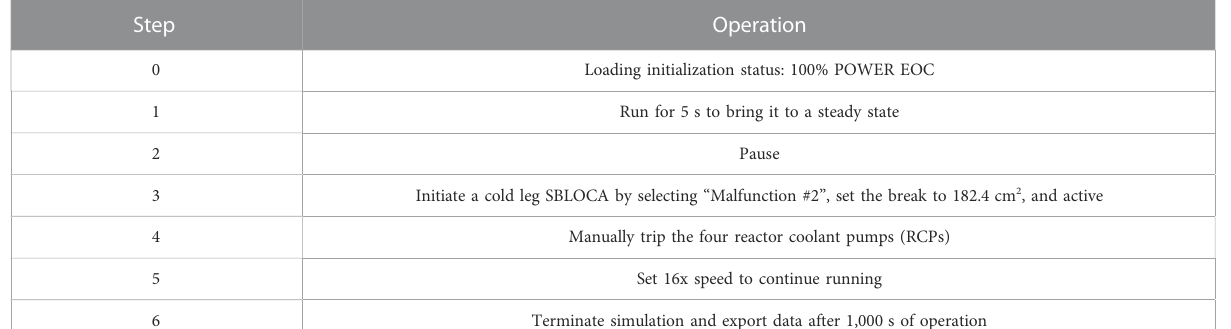
TABLE 4 Steps of SBLOCA-Cold